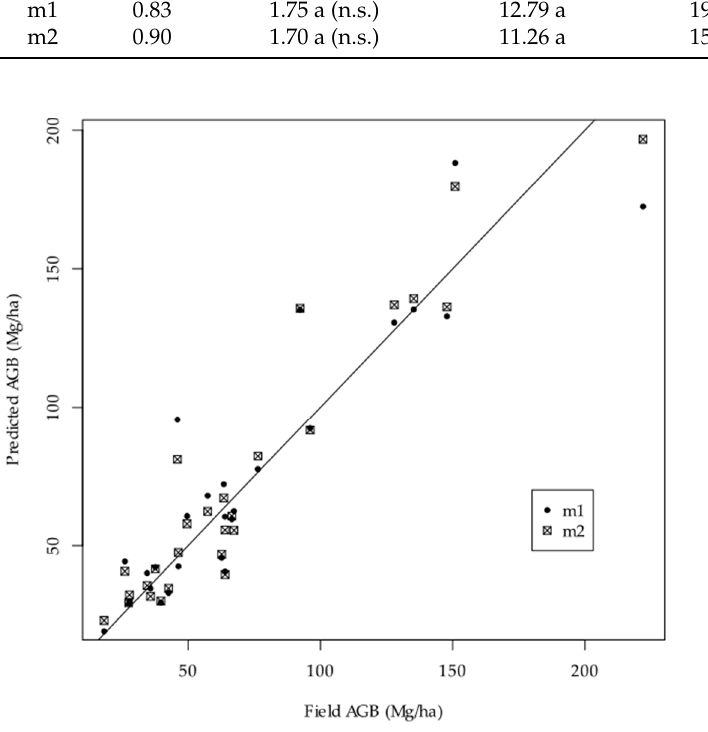
Figure 5. Predicted AGB (Mg/ha) according to field AGB for the 27 plots studied and for the two models m1 (based on CHM) and m2 (based on CHM and point cloud).